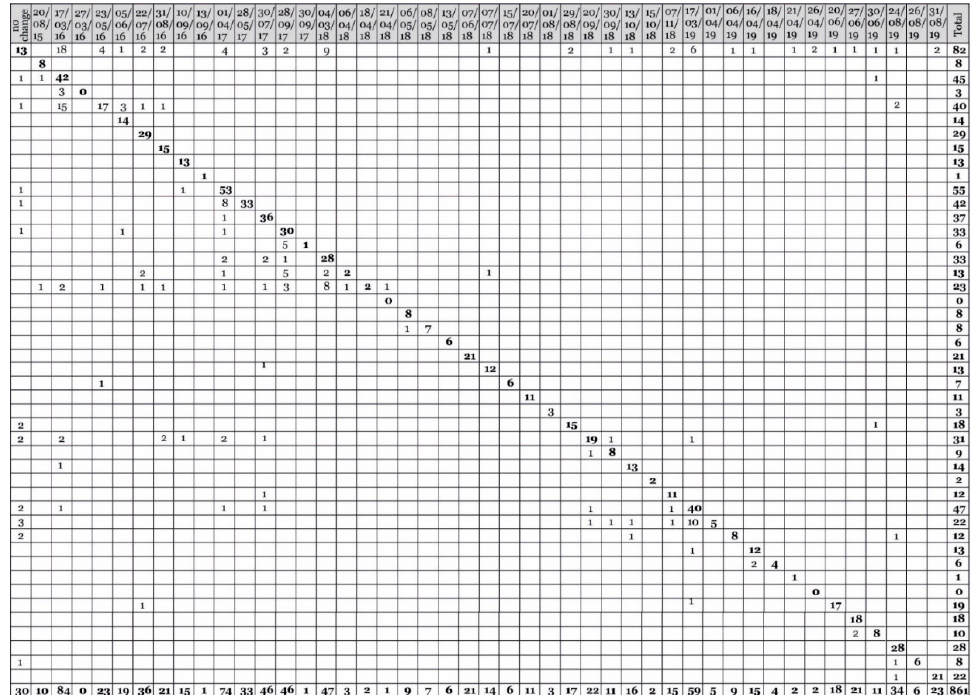
Figure 7. Confusion matrix for the forest change map for the best breaks detection, i.e., SWIR1. Columns represent validation points, and rows represent forest change maps.